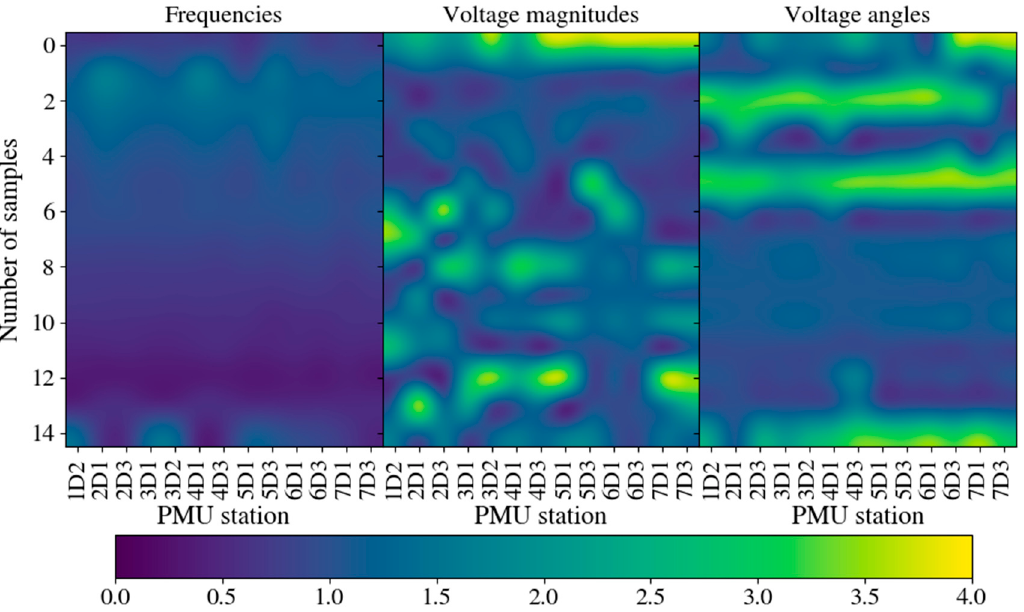
Figure 19. Example frequency ( top and bottom left ), voltage magnitude ( top and bottom middle ) and voltage angle ( top and bottom right ) patterns for low to medium anomaly scores ( top left to right ) and high anomaly scores ( bottom left to right ).